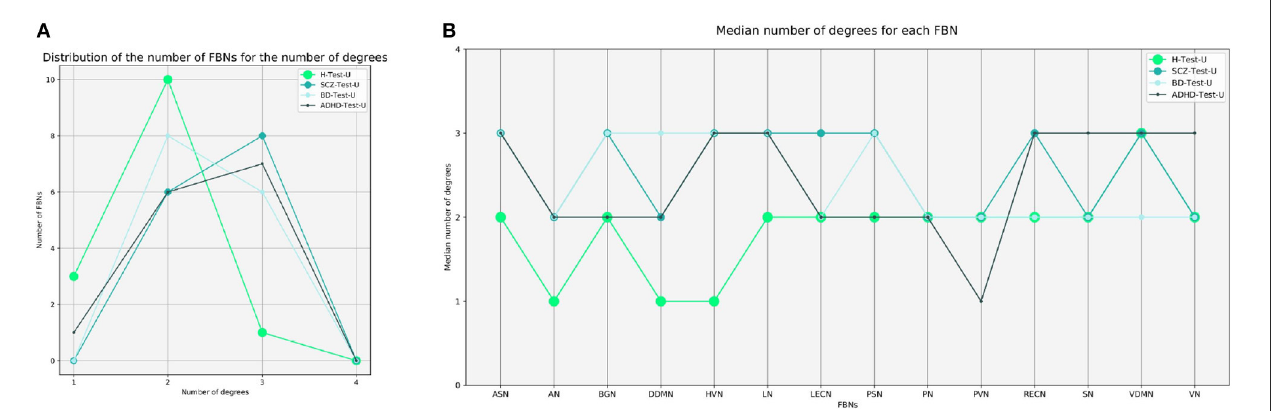
FIGURE2 Graph theory analysis. (A) Distribution of the number of FBNs for the number of degrees, for the H-Test-U, SCZ-Test-U, BD-Test-U, and ADHD-Test-U groups. (B) Representation of the median number of degrees for each FBN, for the H-Test-U, SCZ-Test-U, BD-Test-U, and ADHD-Test-U groups. FBNs, functional brain networks; ASN, anterior salience network; AN, auditory network; BGN, basal ganglia network; DDMN, dorsal default mode network; HVN, higher visual network; LN, language network; LECN, left executive control network; PSN, posterior salience network; PN, precuneus network; PVN, primary visual network; RECN, right executive control network; SN, sensorimotor network; VDMN, ventral default mode network; VN, visuospatial